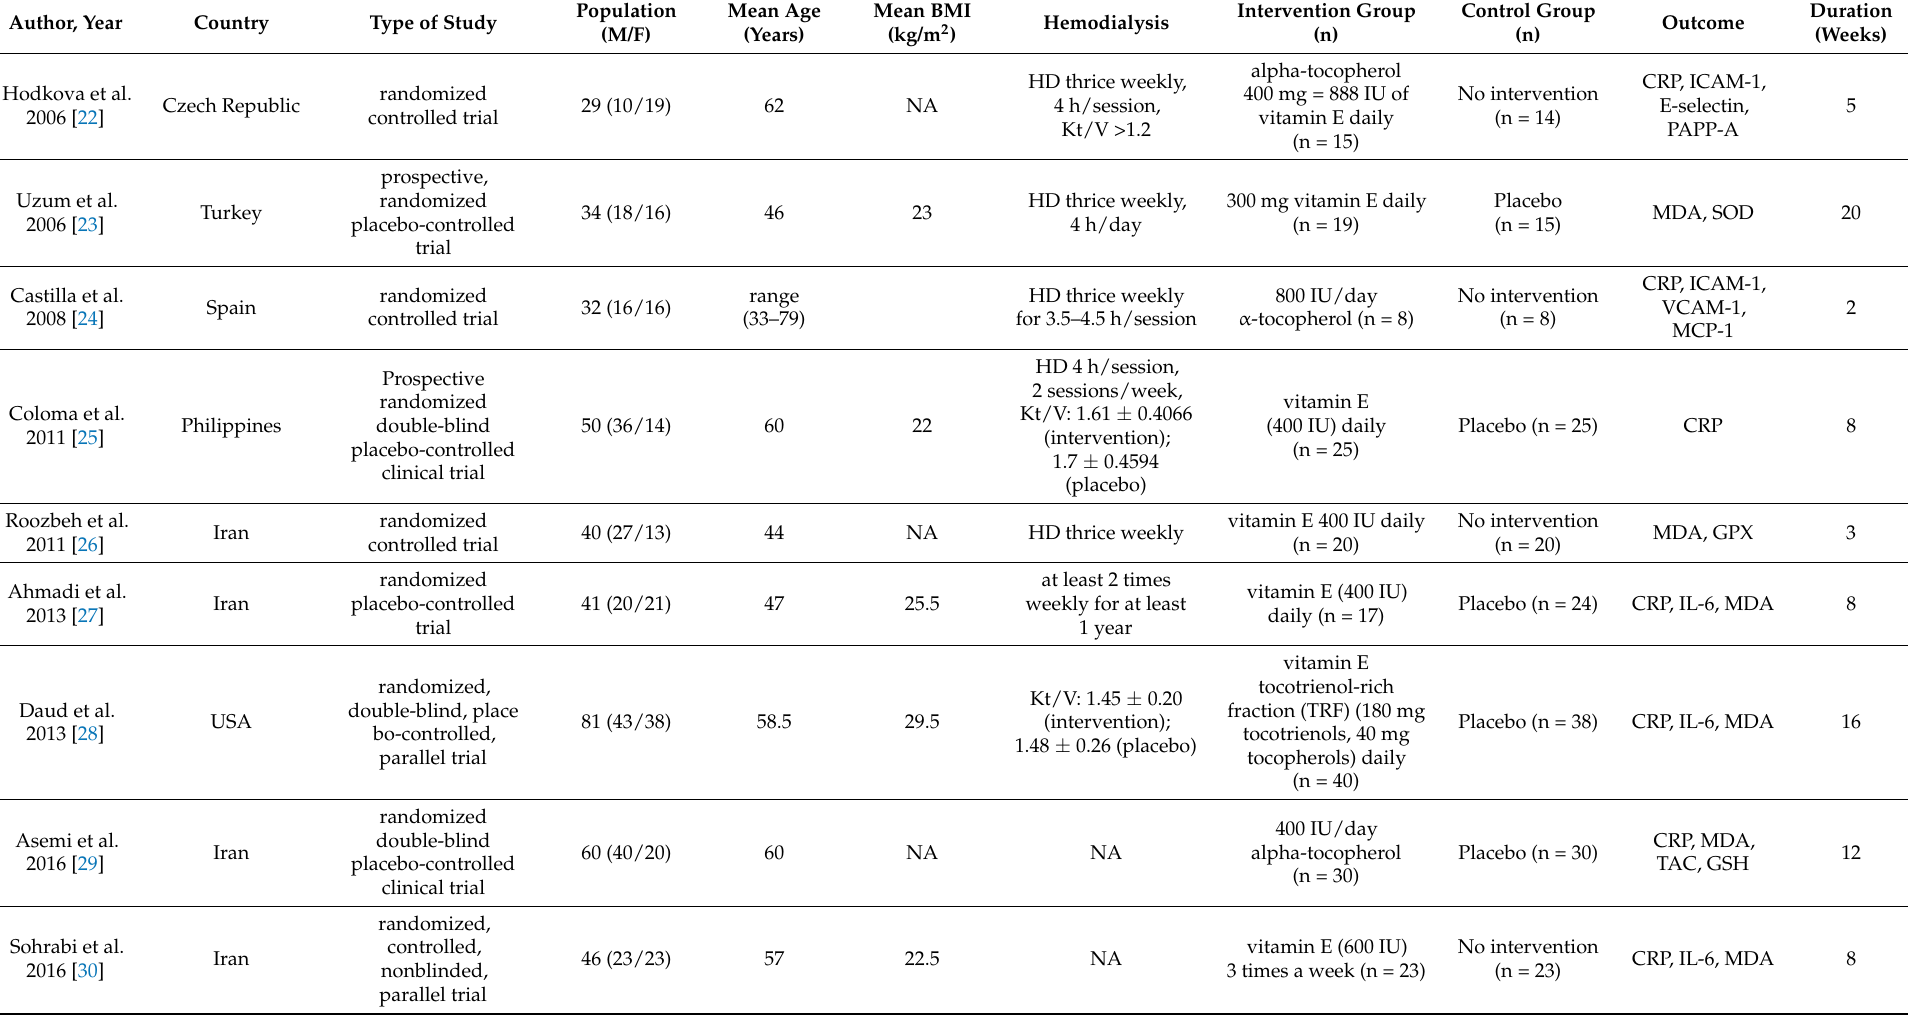
Table 1. Characteristics of the included randomized controlled trials in the systematic